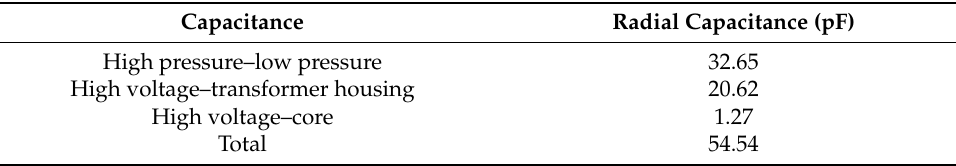
Table 5. Radial capacitance of a single-wire